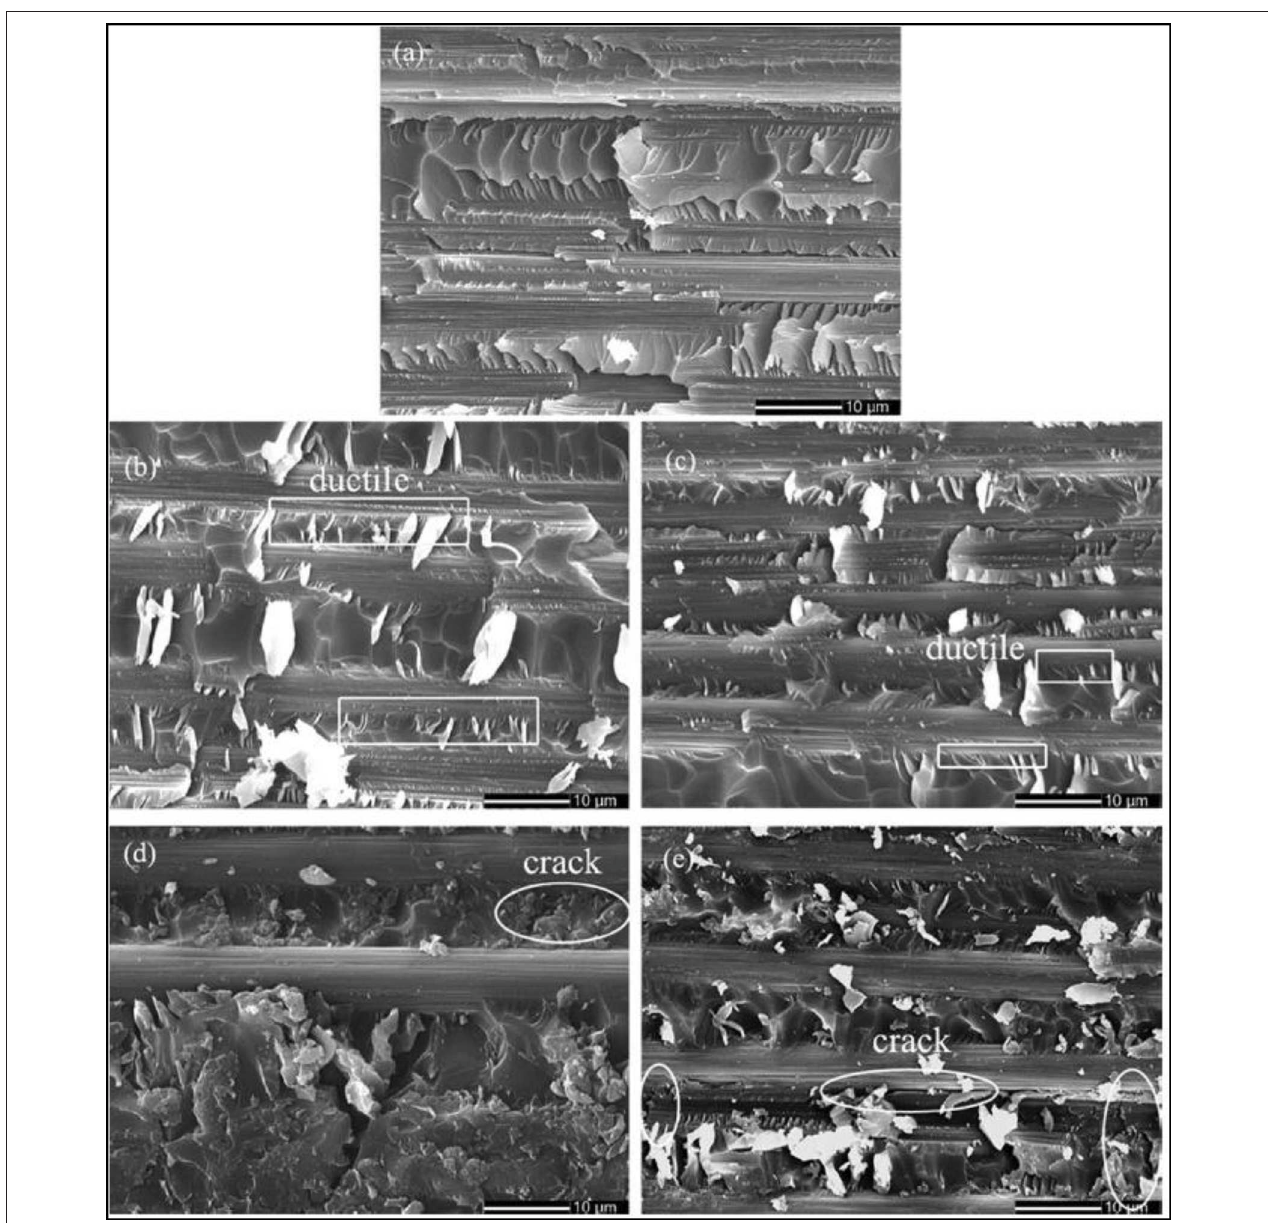
FIGURE 5 | SEM images of fractured surfaces of (a) CF/epoxy composite and (b) CF/epoxy composite with 0.1% w/w GO, (c) 0.1% w/w rGO, (d) 0.4% w/w GO, and (e) 0.4% w/w rGO. Reproduced from Li et al.